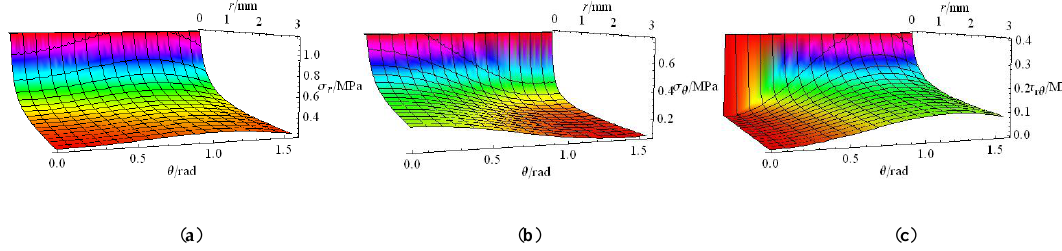
σ θ , ( c ) τ r , ( b ) r θ